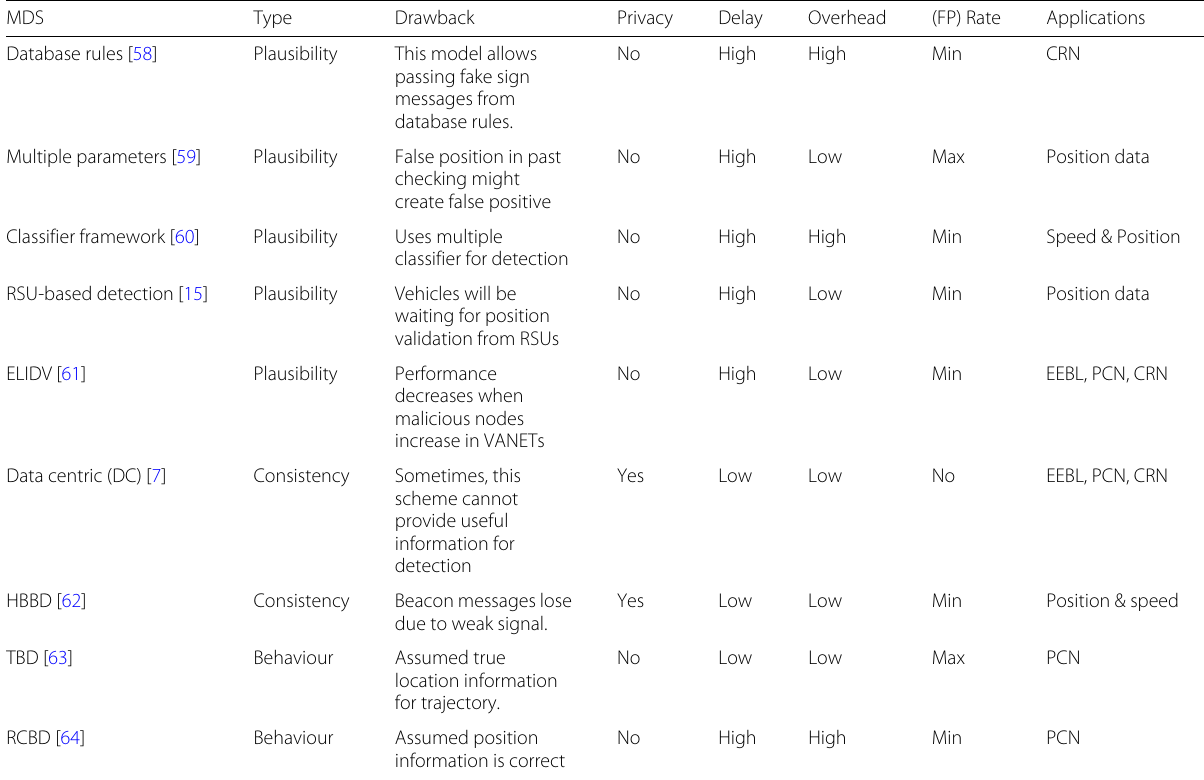
Table 1 Local-based detection